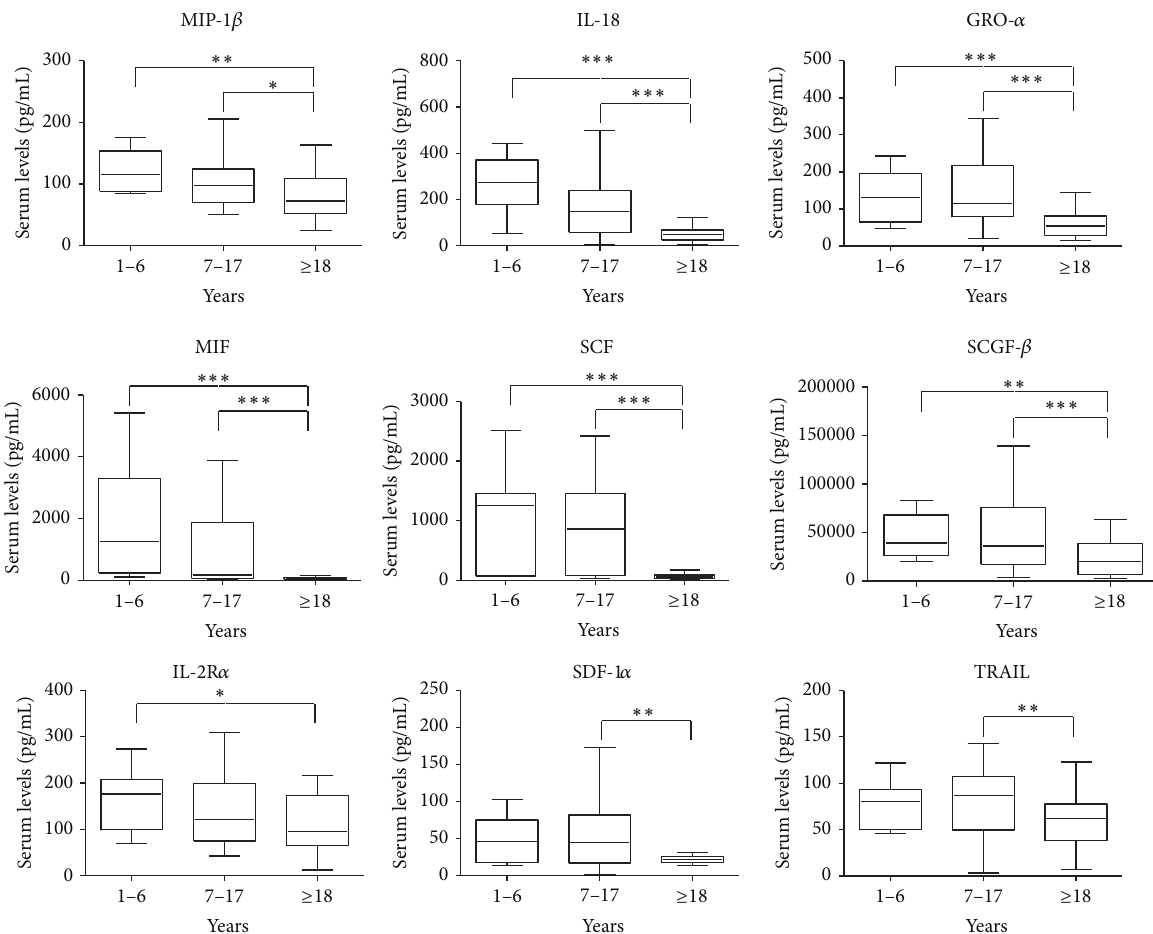
Figure 1: Box plots of serum levels (pg/mL) of cytokines MIP-1 𝛽 , IL-18, GRO- 𝛼 , MIF, SCF, SCGF- 𝛽 , IL-2R 𝛼 , SDF-1 𝛼 , and TRAIL for young children (1–6), children (7–17), and adults ( ≥ 18). Whiskers calculated adopting the Tukey method. Outliers not shown. ∗ 𝑃 < 0.05 , ∗∗ 𝑃 < 0.01 , ∗∗∗ 𝑃 < 0.001 : Kruskal-Wallis test followed by Dunn’s multiple comparison test.